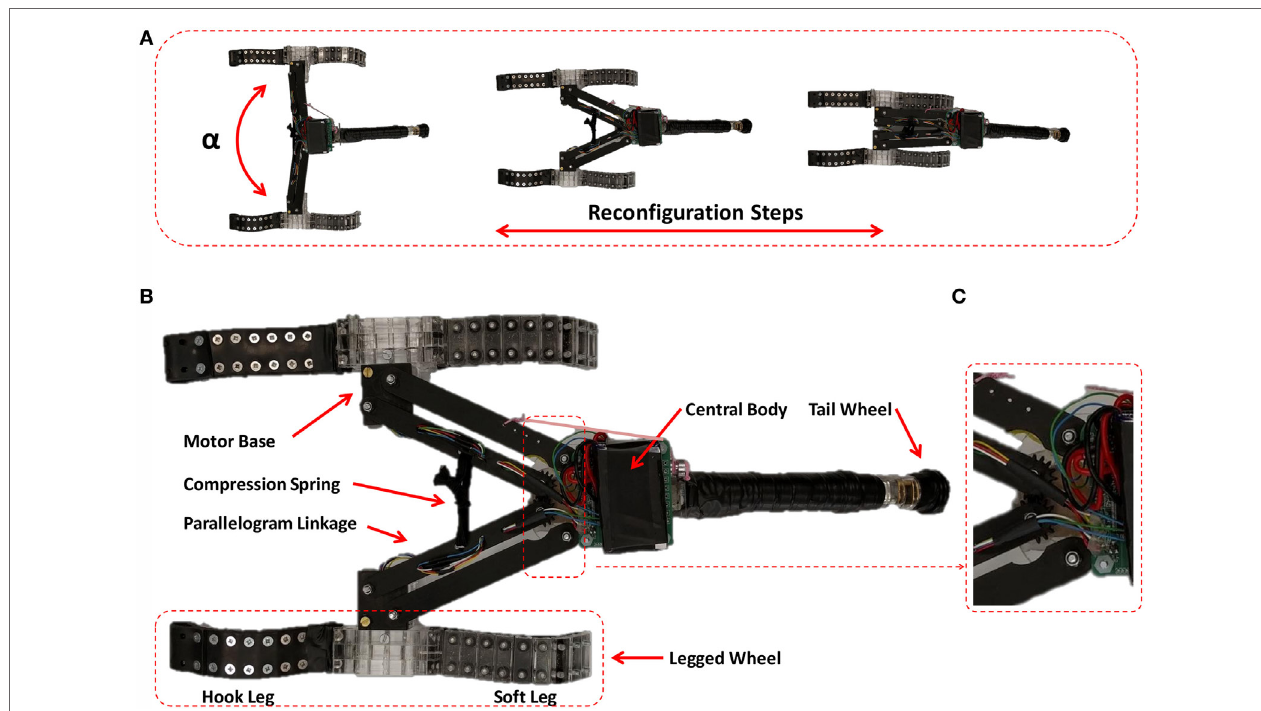
FigUre 2 | (a) Robot can reconfigure from a T to Y shape and vice versa . (B) Top view of the robot with wheels equipped with soft legs. (c) Close view of gear-coupling of left and right parallelogram linkages.